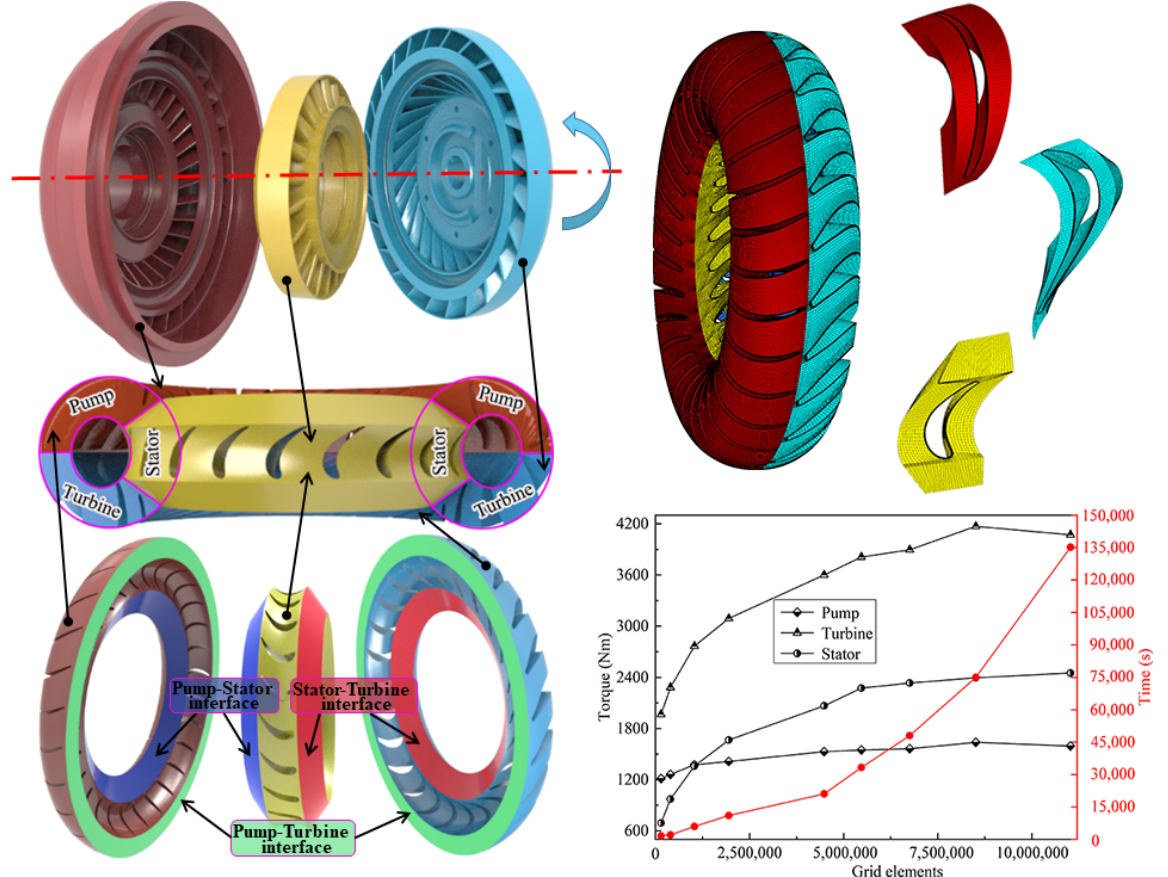
Figure 6. CFD model of the hydrodynamic torque converter and grid independence study. Table 2. CFD model